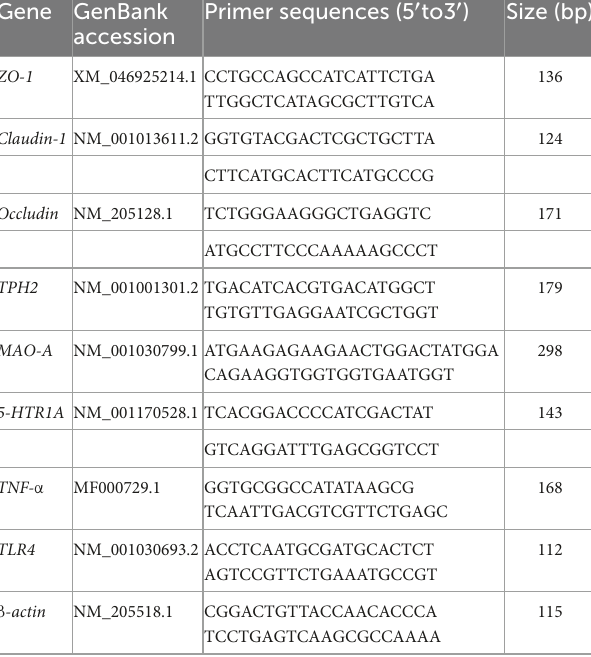
TABLE 2 Primer sequences used for real-time PCR. Gene GenBank